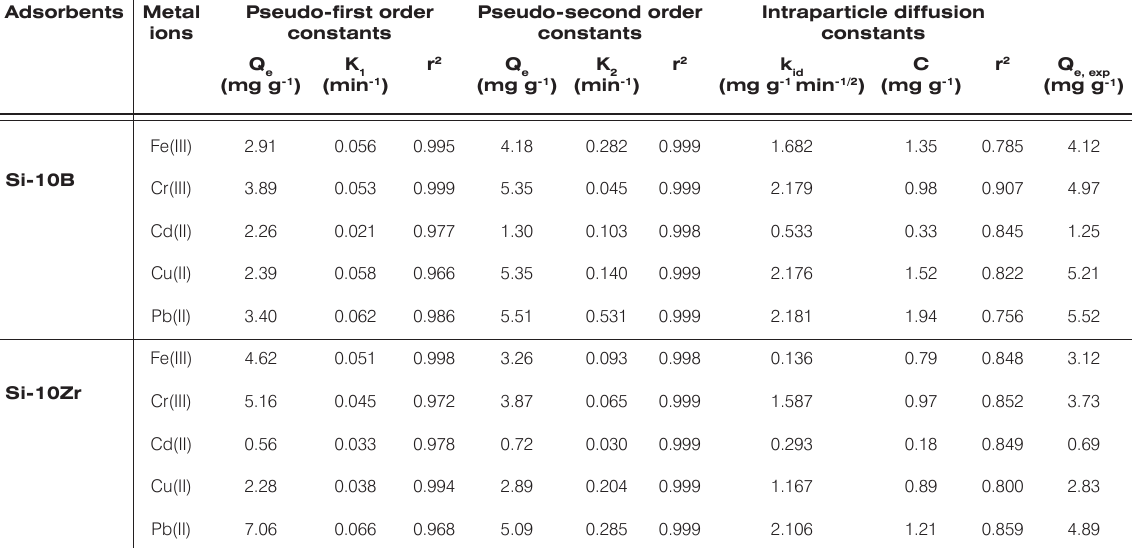
Table 1. Kinetic parameters of adsorption of Fe(III), Cr(III), Cd(II), Cu(II) and Pb(II) ions from aqueous solutions onto Si-10B and Si-10Zr. Adsorbents Metal